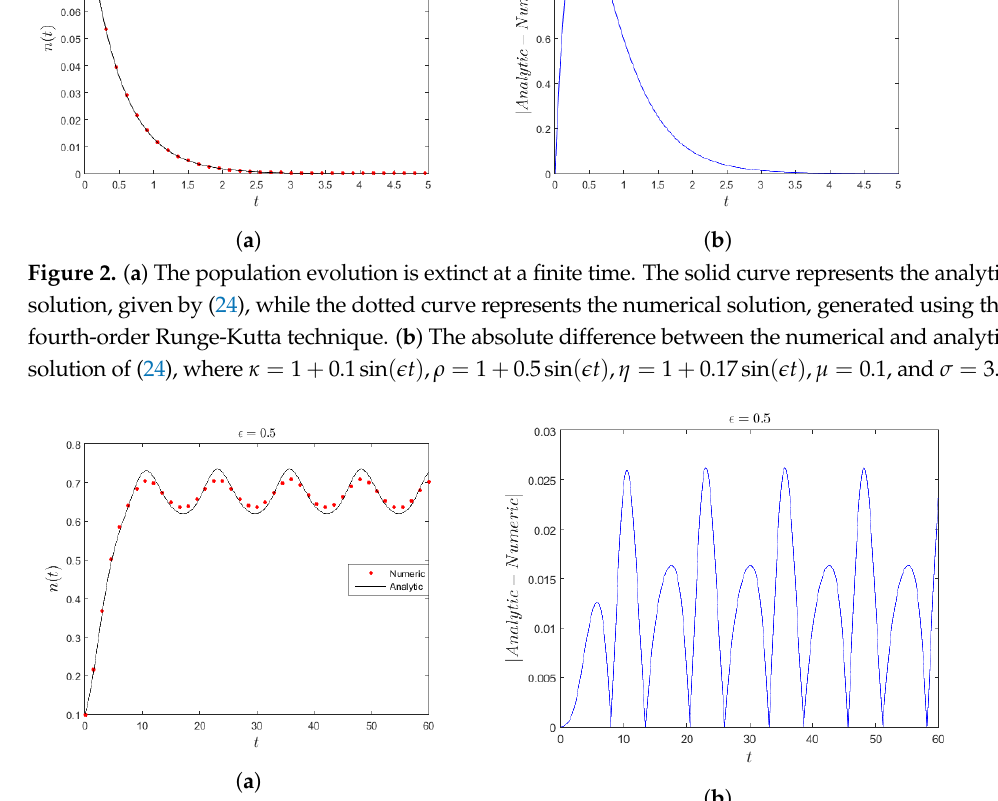
Figure 3. ( a ) The population evolution survives at the equilibrium state. The solid curve represents the analytic solution, given by (24), while the dotted curve represents the numerical solution, generated using the fourth-order Runge-Kutta technique. ( b ) The absolute difference between the numerical and analytic solution of (24), where κ = 1 + 0.1sin ( (cid:101) t ) , ρ = 1 + 0.17sin ( (cid:101) t ) , η = 1 + 0.5sin ( (cid:101) t ) , µ = 0.1, and σ = 0.33 <